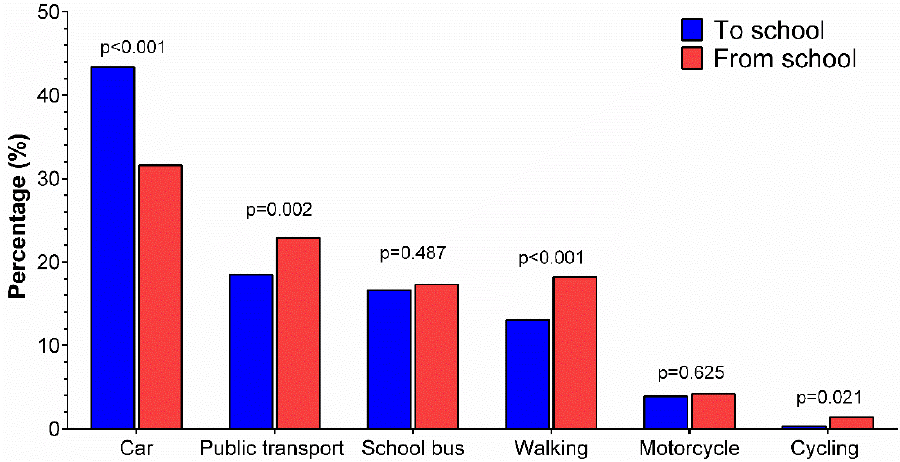
Figure 1. Mode of commuting to and from school for the whole sample.